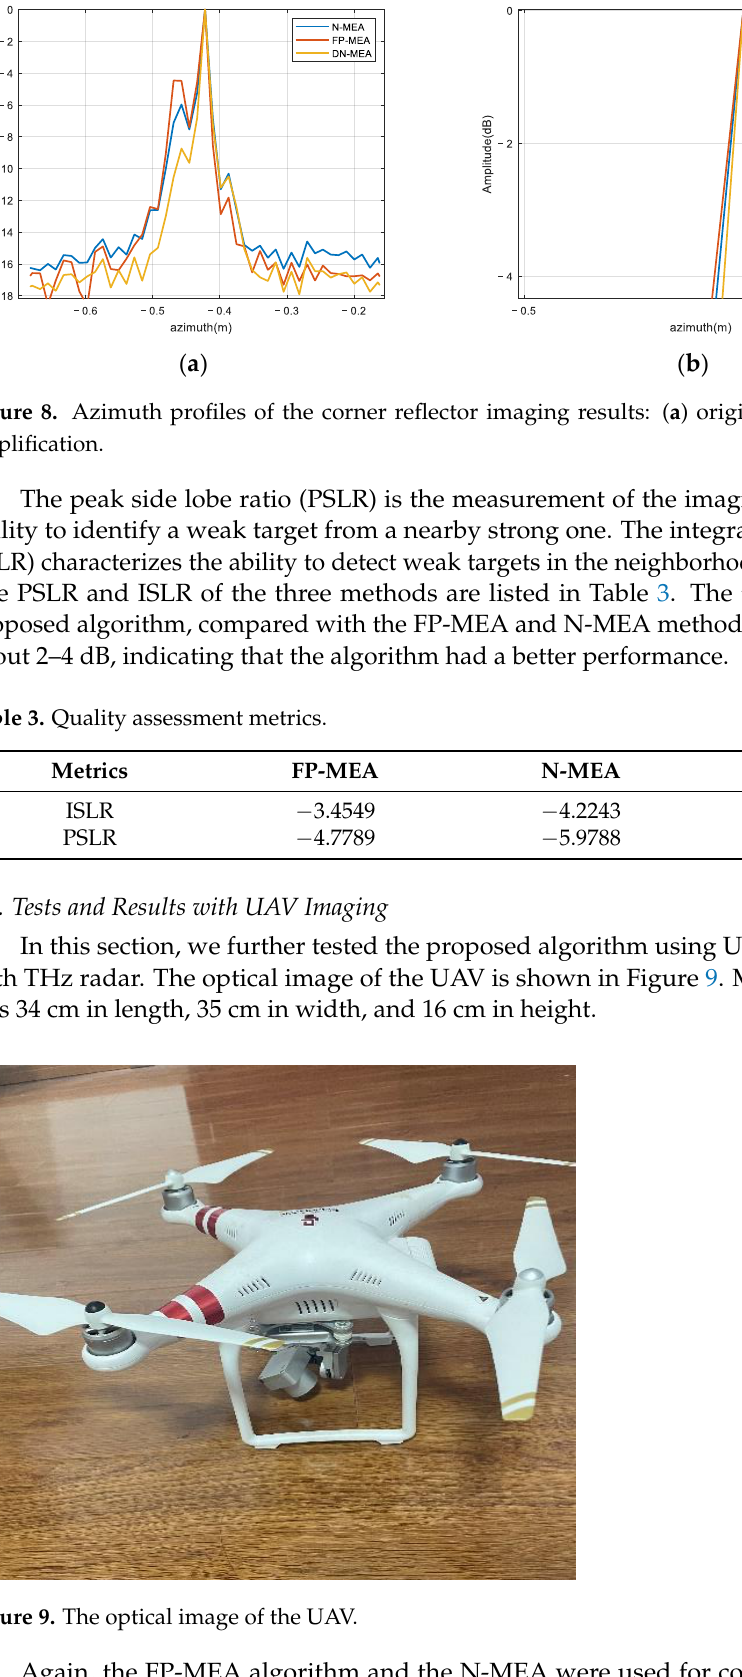
Figure 9. The optical image of the